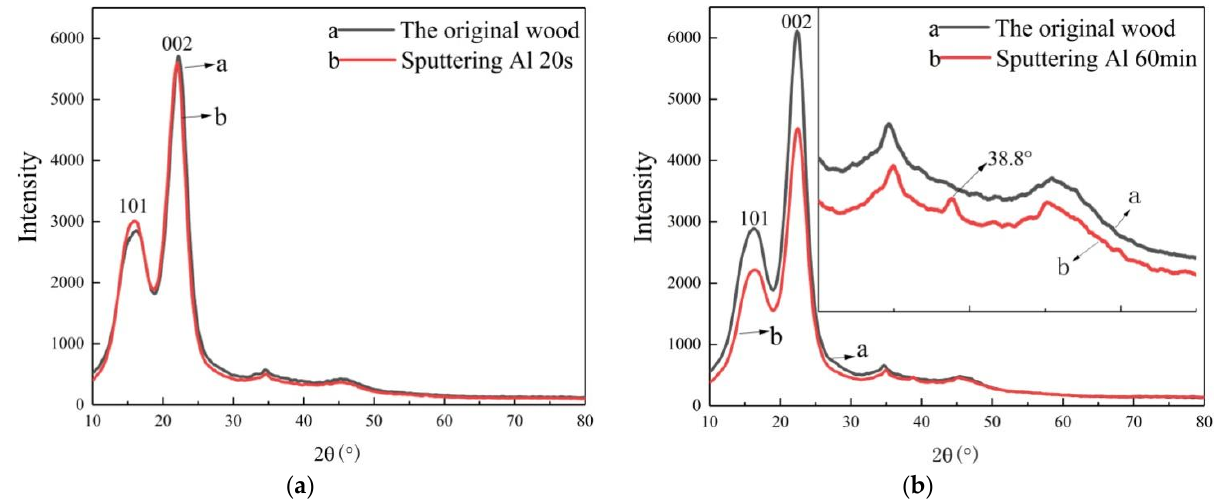
Figure 2. XRD patterns of nano-Al metallized wood. ( a ) Sputtering Al 20 s, ( b ) Sputtering Al 60 min.